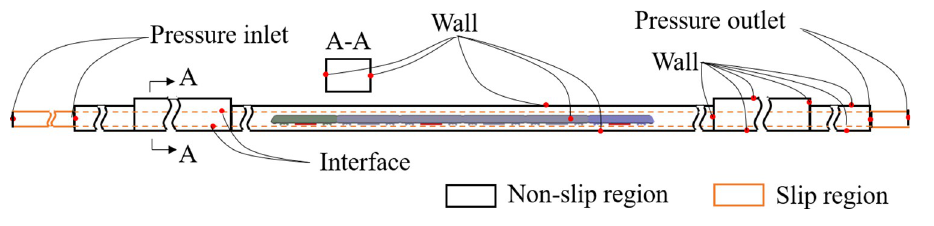
Fig 4. Computational domain and boundary